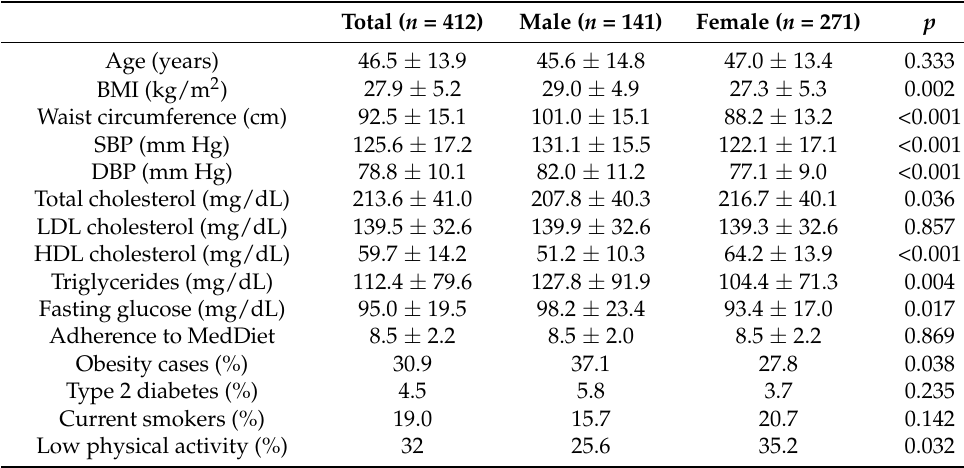
Table 1. Descriptive characteristics of the studied sample and those per